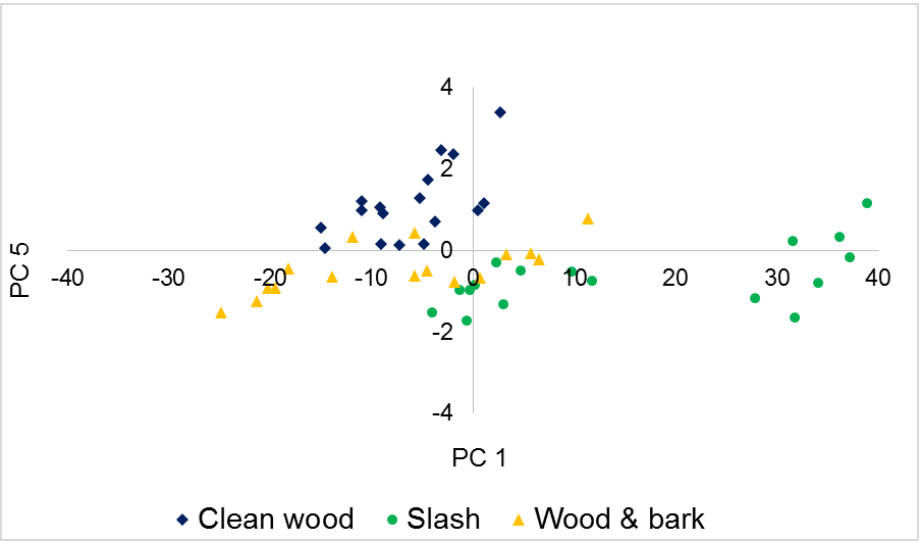
Figure 5. FTIR scores plot of PC 1 versus PC 5.